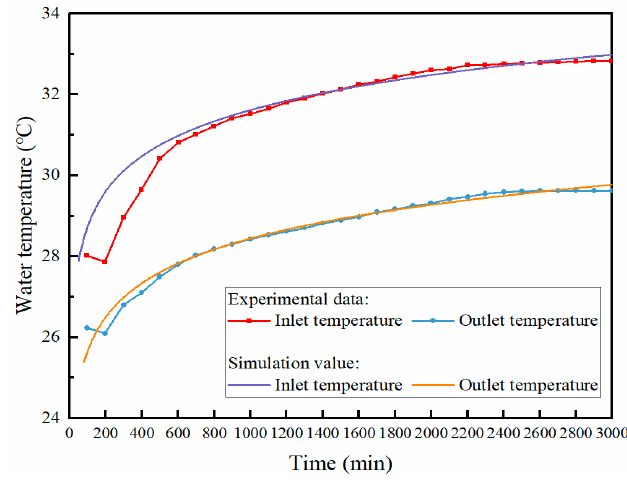
Figure 7. Measured and simulated variations of inlet and outlet temperatures.